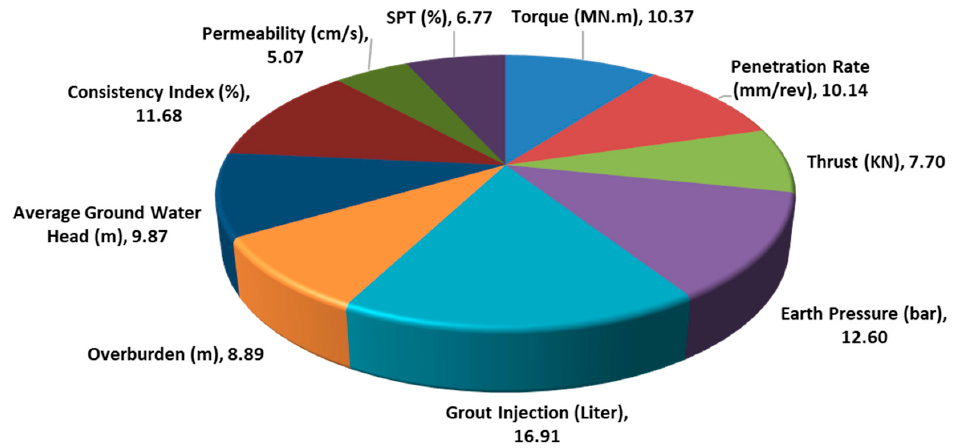
Figure 11. The impact of each input parameter on the se tt lement rate